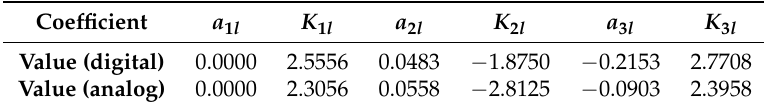
Table 2. Values of the coefficients for the linear regression in Equations (5)–(7).